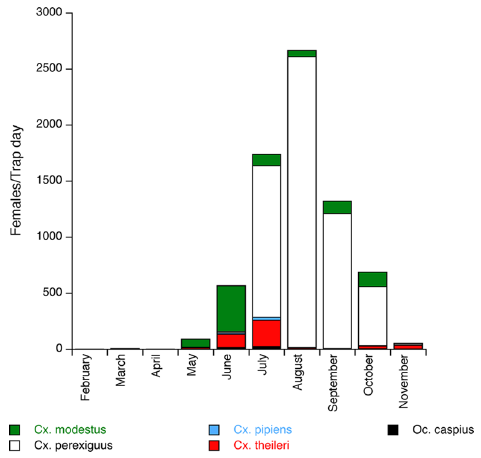
Figure 1. Mean number of female mosquitoes captured per day of trapping for the five species screened for blood